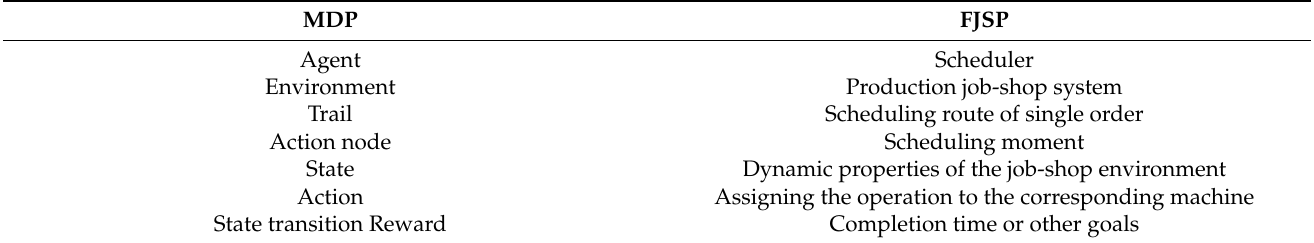
Table 1. The connection between MDP and